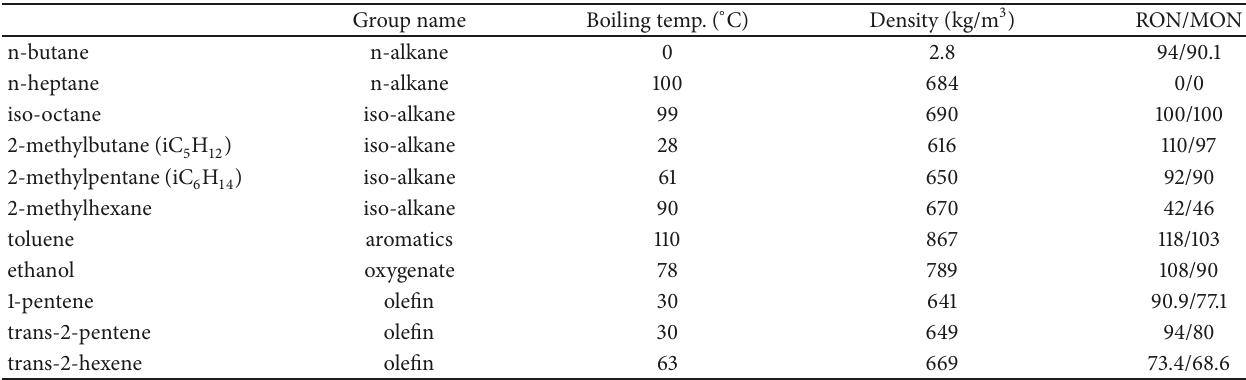
Table 2: Some of the gasoline fuel component